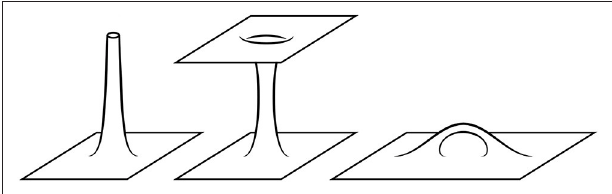
FIGURE 4 | Wormholes: A semiwormhole (Left) , a wormhole connecting two distinct large asymptotically flat universes (Center) and a wormhole on a single universe (Right)